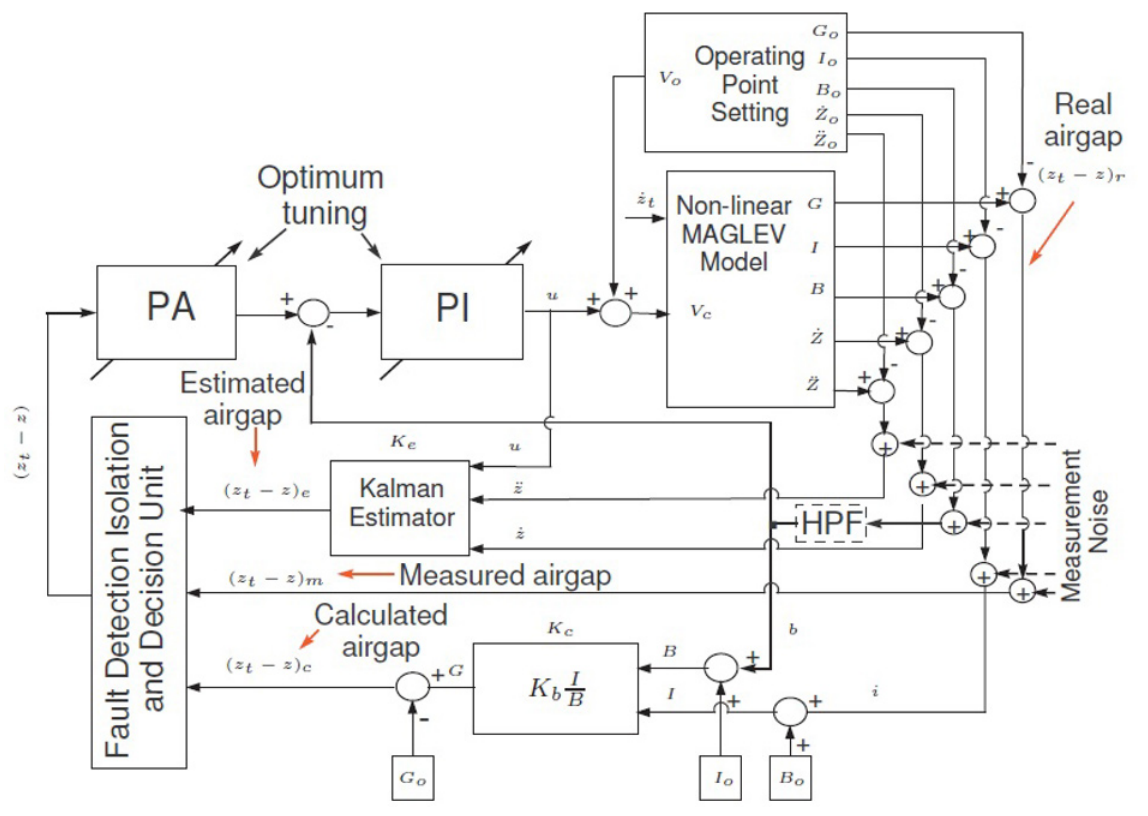
Figure 5. Fallback options for airgap sensor failure of the MAGLEV suspension